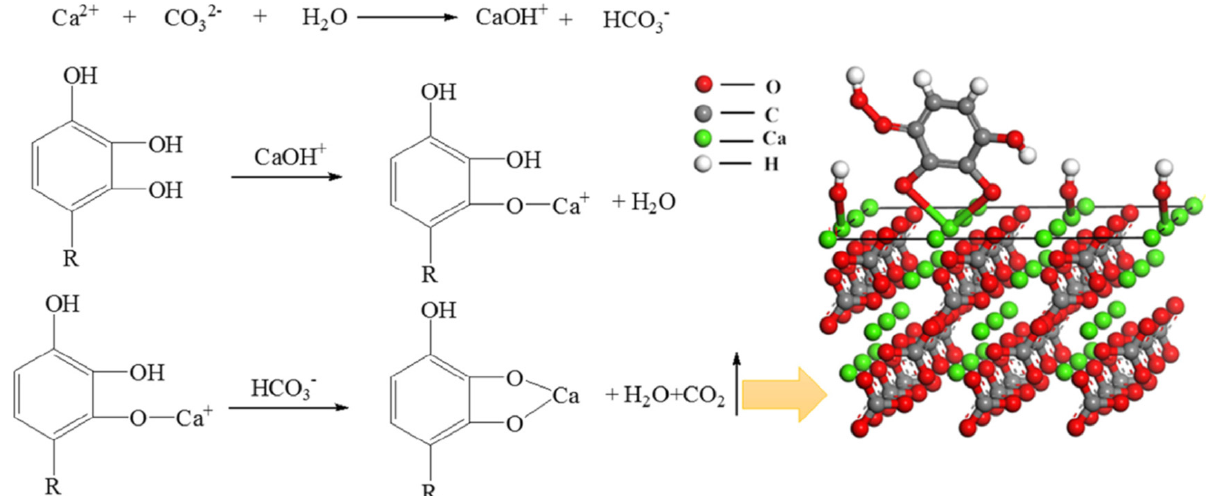
Figure 8. Proposed adsorption process and model for tannic acid.